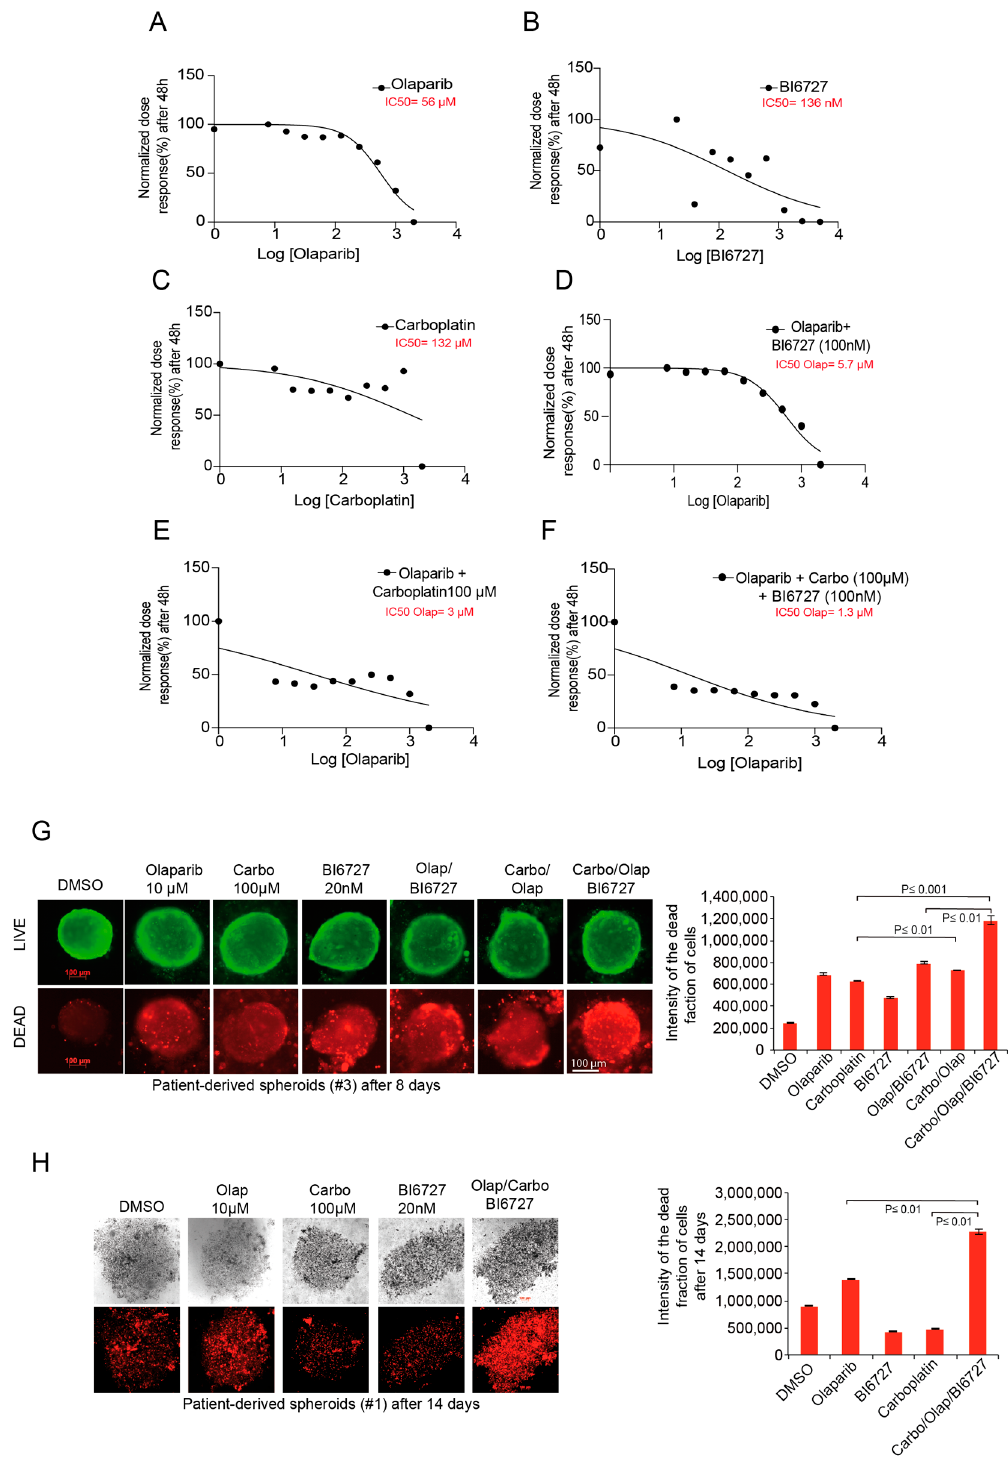
Figure 6. PARPi and PLK1i combination strongly enhances apoptosis-dependent death of patients- derived tumor cells. ( A – C ) Primary tumor cells of patients were treated with increasing concentrations of Olaparib, BI6727, and Carboplatin as single agents or combinations ( D – F ). The cell viability was determined after 48 h, and the IC 50 of the different agents was calculated. ( G , H ) 3D cultures grown from tumor cells of patients were treated with 10 µM Olaparib, 20 nM BI6727, and 100 µM Carboplatin as single or combinatorial treatments for 8 days. Cells were stained, and the fraction of dead cells was quantified using immunofluorescence. The results are presented as mean ± SD and statistically analyzed (n = 5 , p ≤ 0.001, p ≤ 0.01).